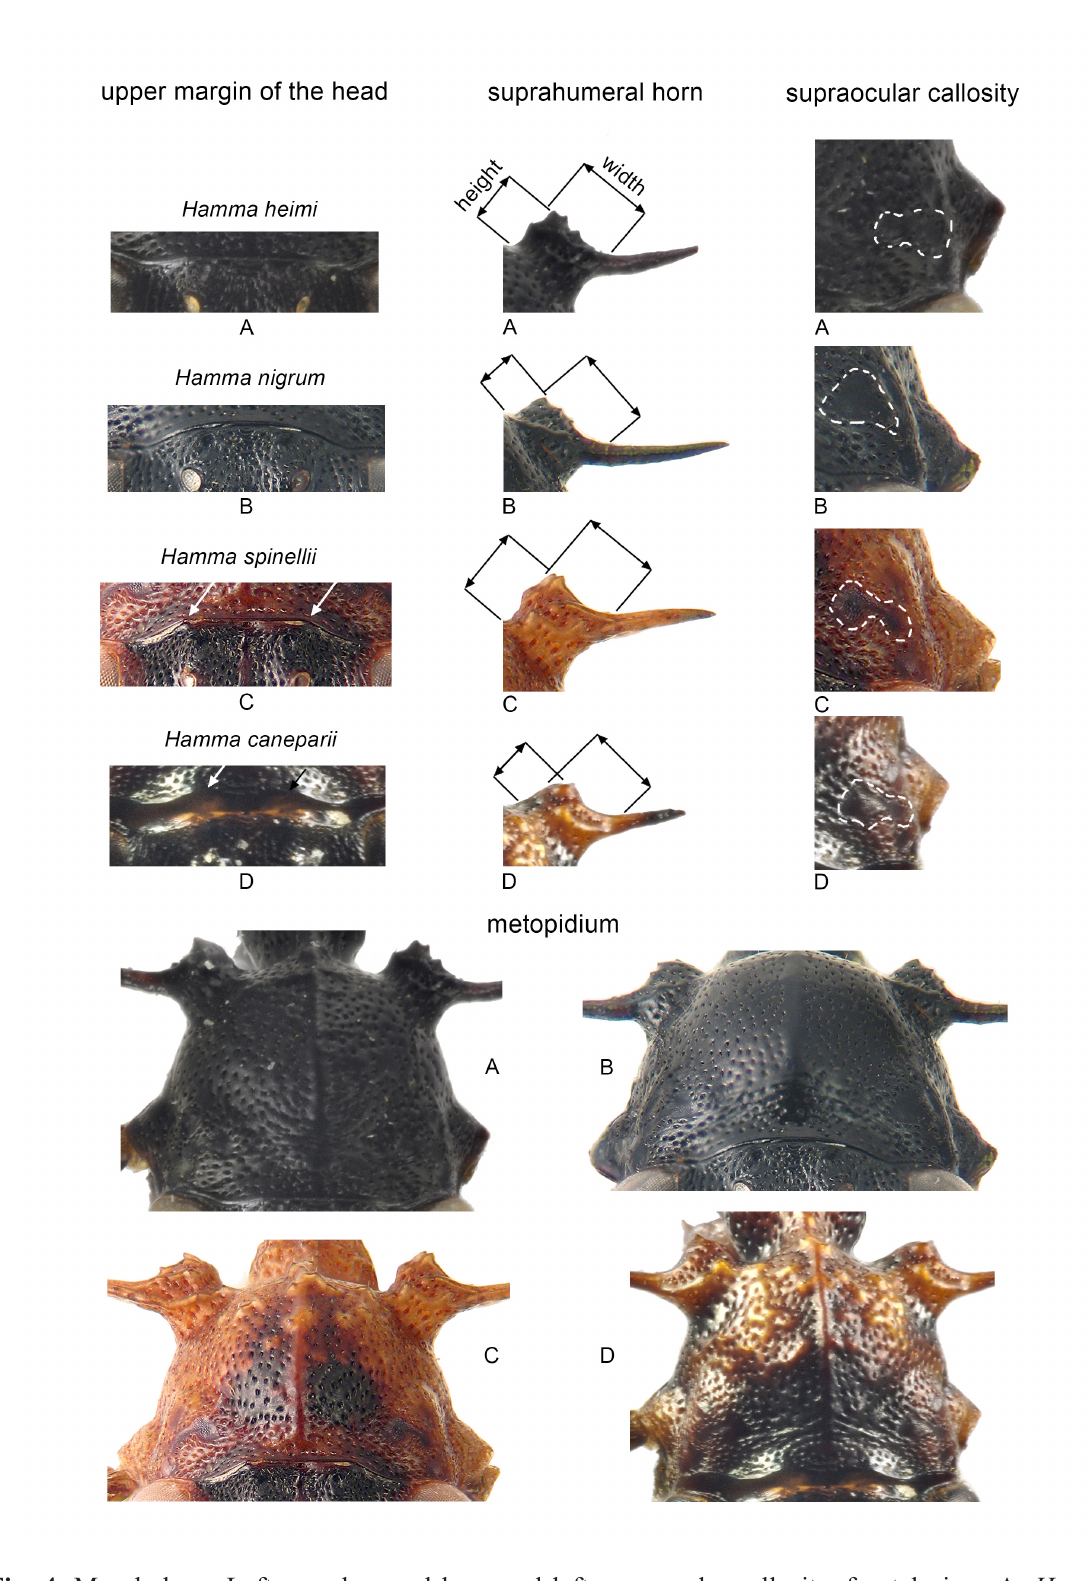
Fig. 4. Morphology. Left suprahumeral horn and left supraocular callosity, frontal view. A . Hamma heimi Boulard, 1968. B . Hamma nigrum sp. nov. C . Hamma spinellii sp. nov. D . Hamma caneparii sp. nov. Figures are not to